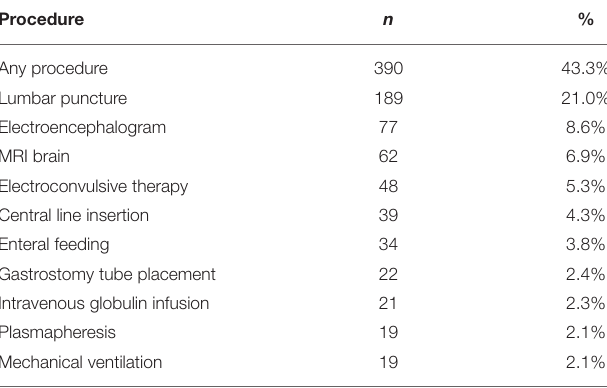
TABLE 4 | Top 10 procedures performed during hospitalization based on number of hospitalizations including the indicated